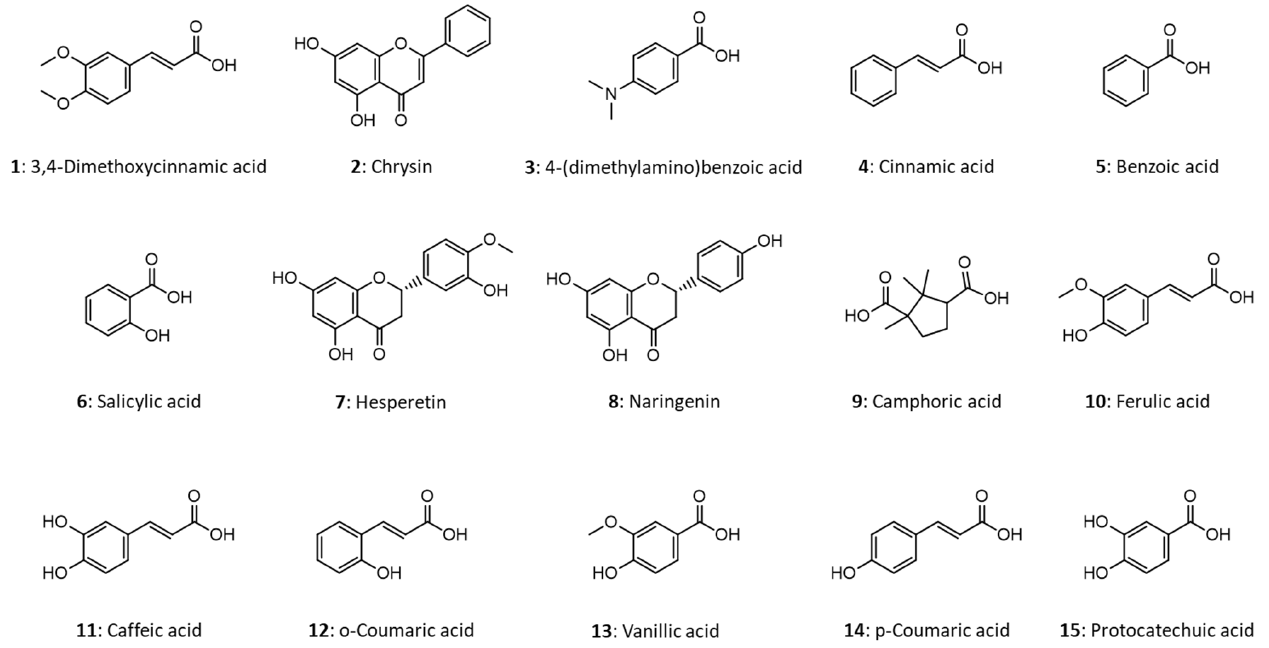
Figure 1. Molecular structures of the phenolic compounds studied.